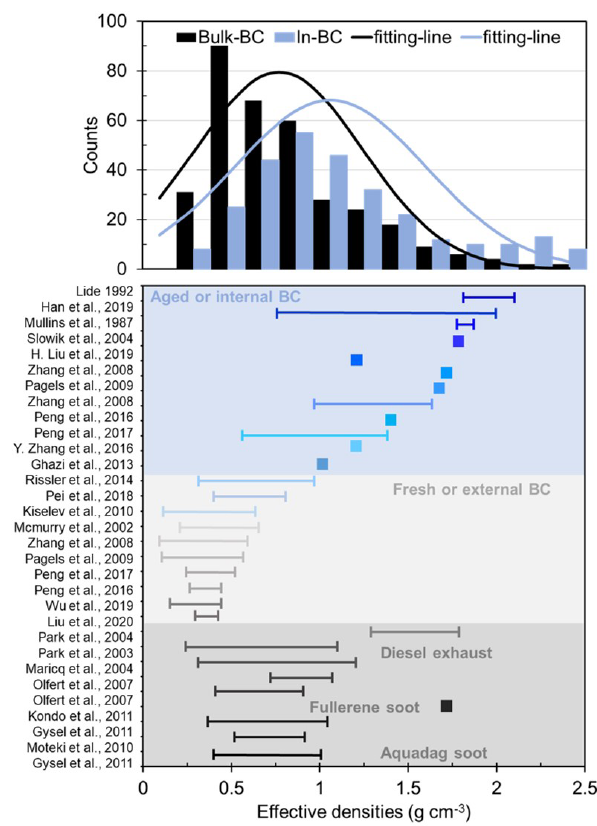
Figure 5. The probability distribution function (PDF) of the re- trieved density of bulk and In-BC and the measured density dis- tribution spectrum of BC from different sources reported in the lit-